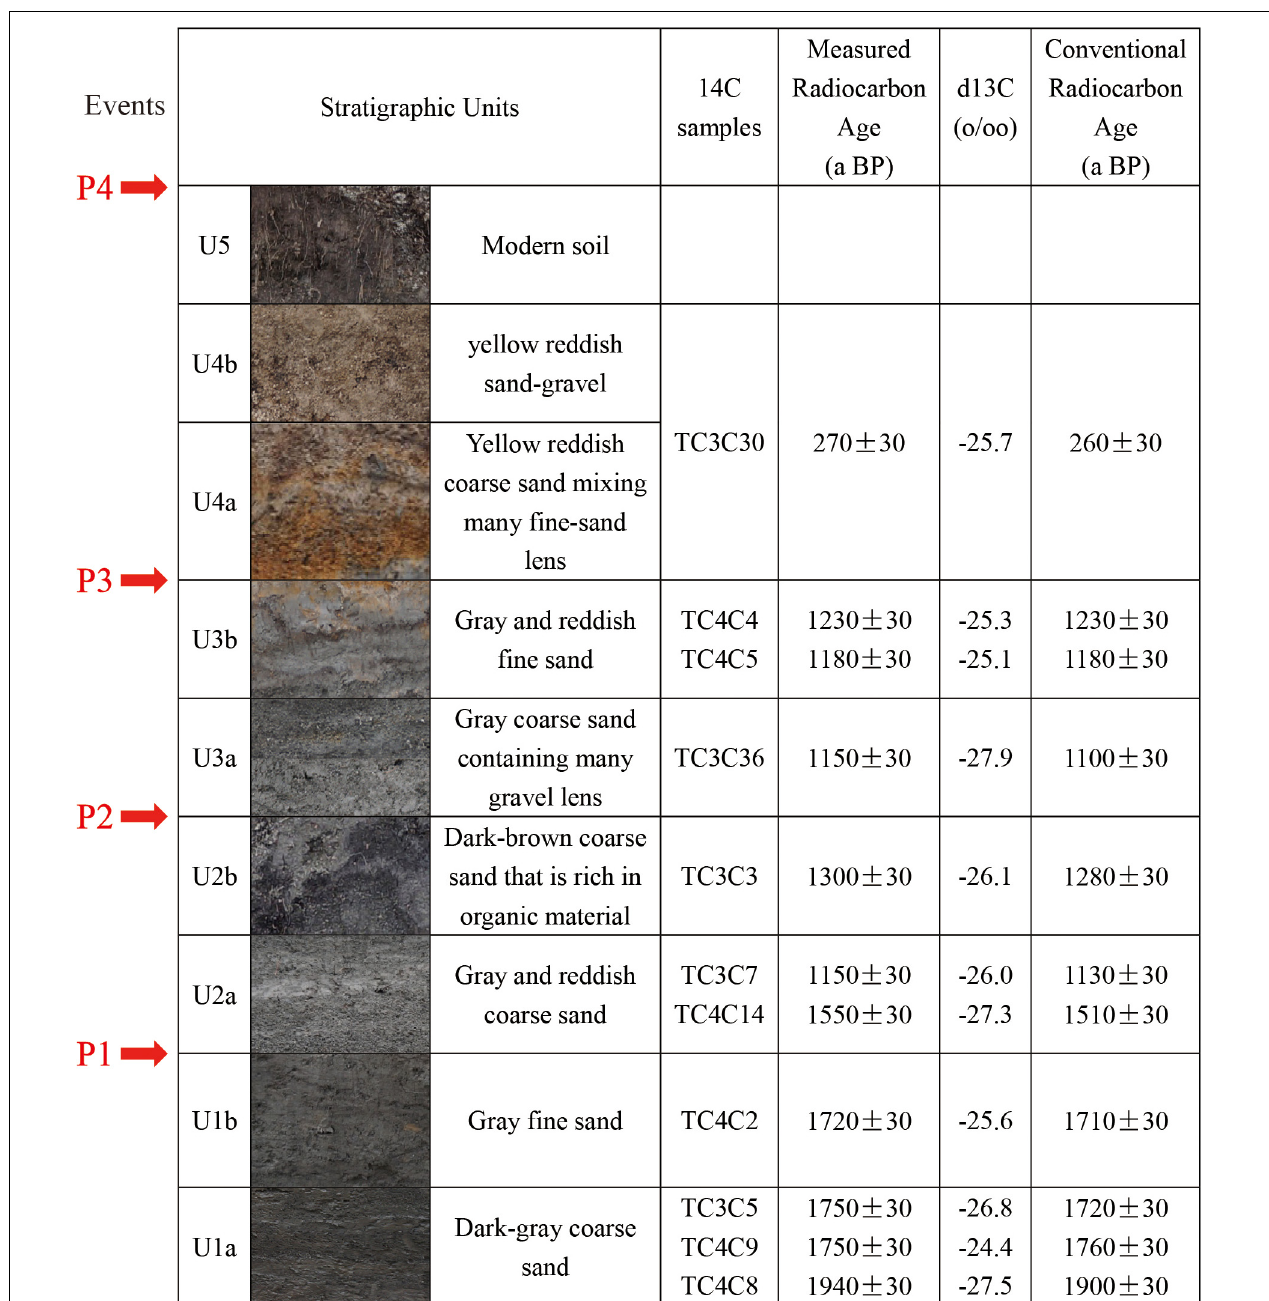
FIGURE 9 | Stratigraphic sequence and radiocarbon dating results of TC2 and TC3 at site 2. All samples were processed at Beta Analytic Inc., Miami, FL, United States.